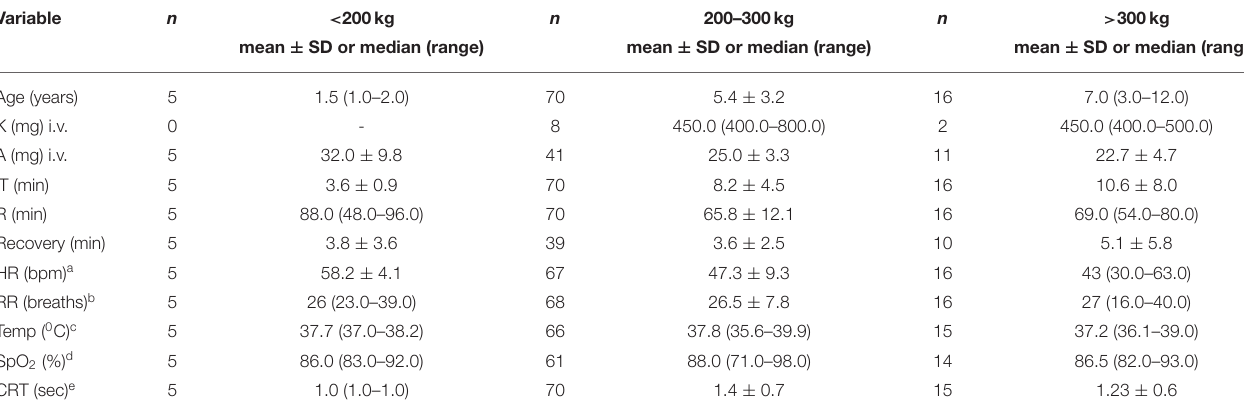
TABLE 1 | Doses, age, times and physiological measurements (given in mean ± SD or median and range) during anesthesia of feral horses in Romania, grouped by body weight. Variable